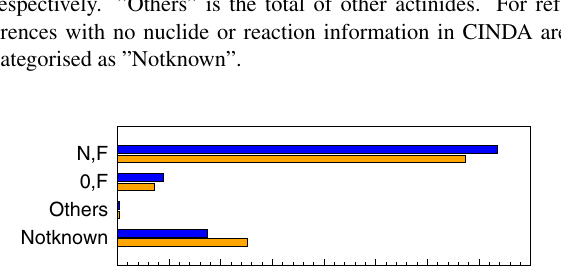
Figure 2. Reaction categories, (N,F): neutron-induced and (0,F): spontaneous fission. See legend to Fig.